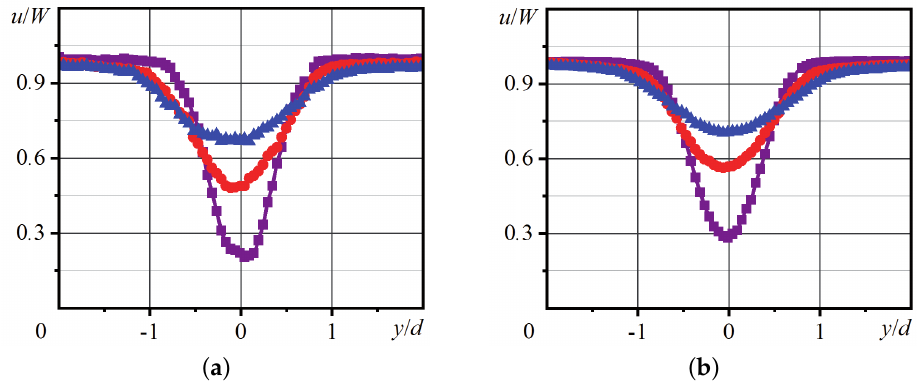
Figure 11. Profiles of the longitudinal velocity component u at: ( a ) Re = 4.8 × 10 3 and ( b ) Re = 20.2 × 10 3 ( S = 2 d : purple curve— x / d = 1.06; red curve— x / d = 1.54; blue curve— x / d =